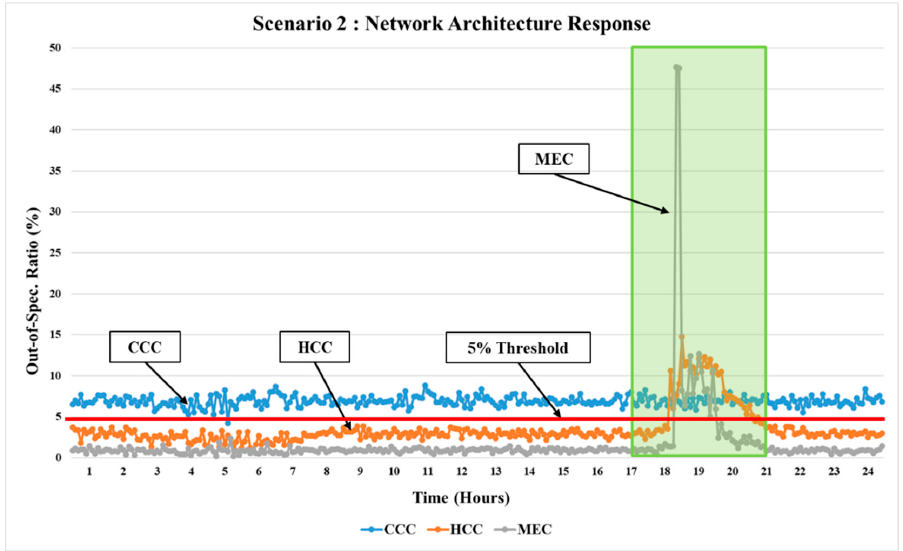
Figure 10. Individual network architecture’s response to data traffic shown in Scenario 2.